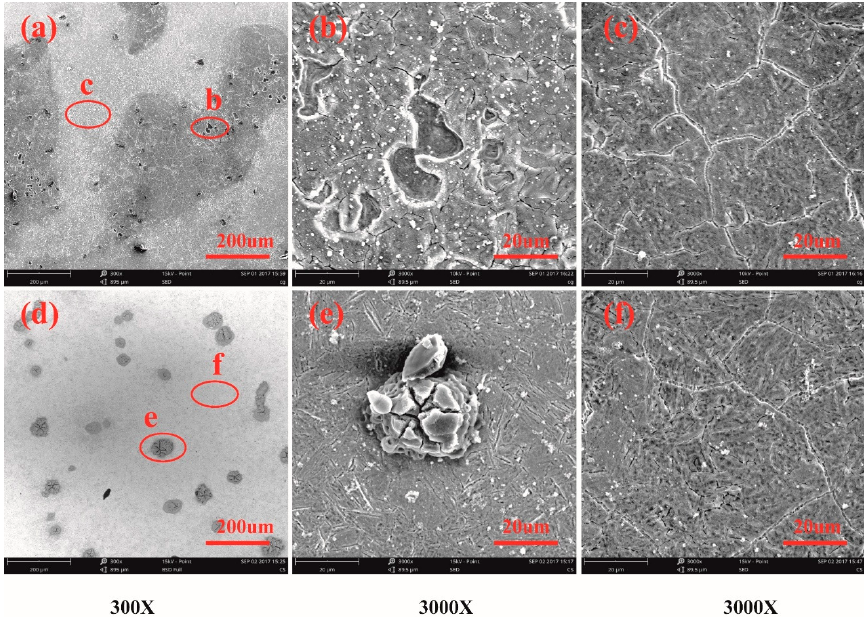
Figure 7. SEM images of the 35CrMoV corrosion surface: ( a – c ) un-ultrasonic-aided; ( d – f ) ultrasonic-aided. Metals 2018 , 8 , x FOR PEER REVIEW